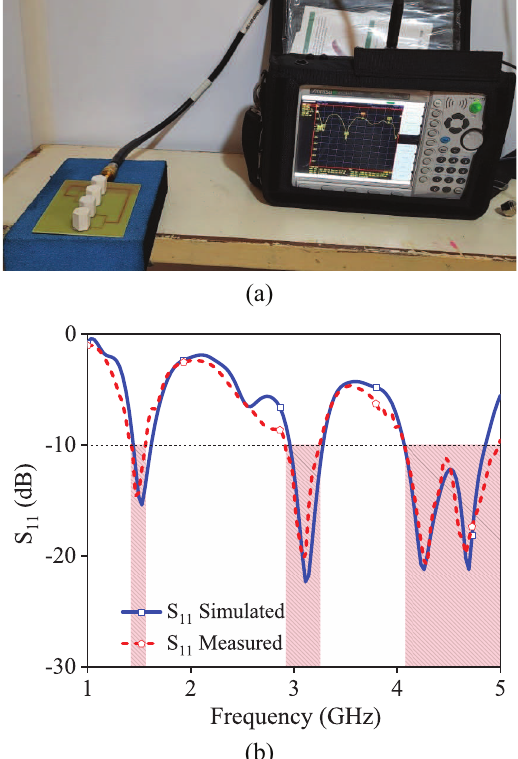
FIGURE 8: Simulated and measured reflection coefficient of proposed HDRA array: (a) Setup (b) S 11 magnitude.